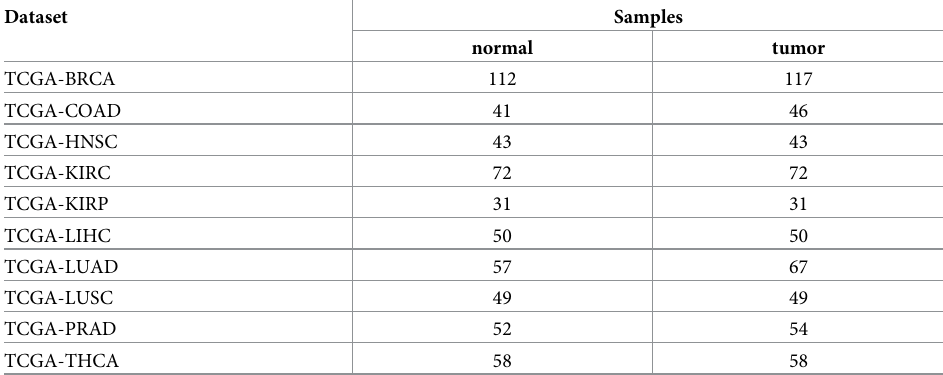
The samples originate from patients for whom samples of tumor tissues and adjacent normal tissues are available. Only the datasets with at least 30 samples for both conditions are analyzed: BRCA (BReast invasive CArcinoma), COAD (COlon ADenocarcinoma), HNSC (Head and Neck Squamous cell Carcinoma), KIRC (KIdney Renal Clear cell carcinoma), KIRP (KIdney Renal Papillary cell carcinoma), LIHC (LIver Hepatocellular Carcinoma), LUAD: (LUng ADenocarcinoma), LUSC (LUng Squamous cell Carcinoma), PRAD (PRostate ADenocarcinoma), and THCA (THyroid CArcinoma). For some datasets, the numbers of samples from normal and tumor tissues are different because several samples from tumors are available and are integrated in the